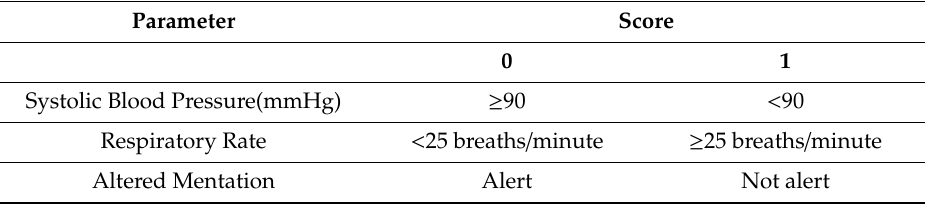
Table 1. Obstetrically modified qSOFA